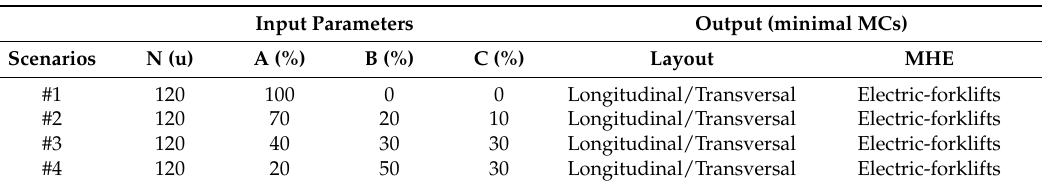
Table 3. Layout and MHE identified in order to minimizing of the Management Costs due to facilities costs (FCs) and Operative Costs (OCs).